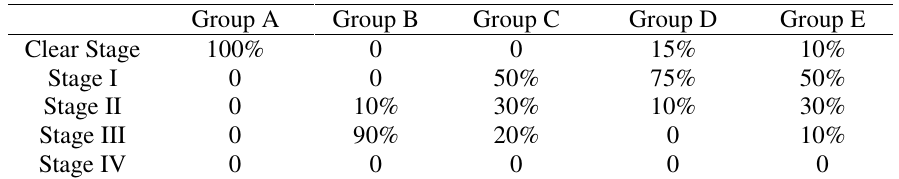
Table 3. Effect of Triphala ghrita on the onset of galactose- induced cataract in rats observed after 21 days